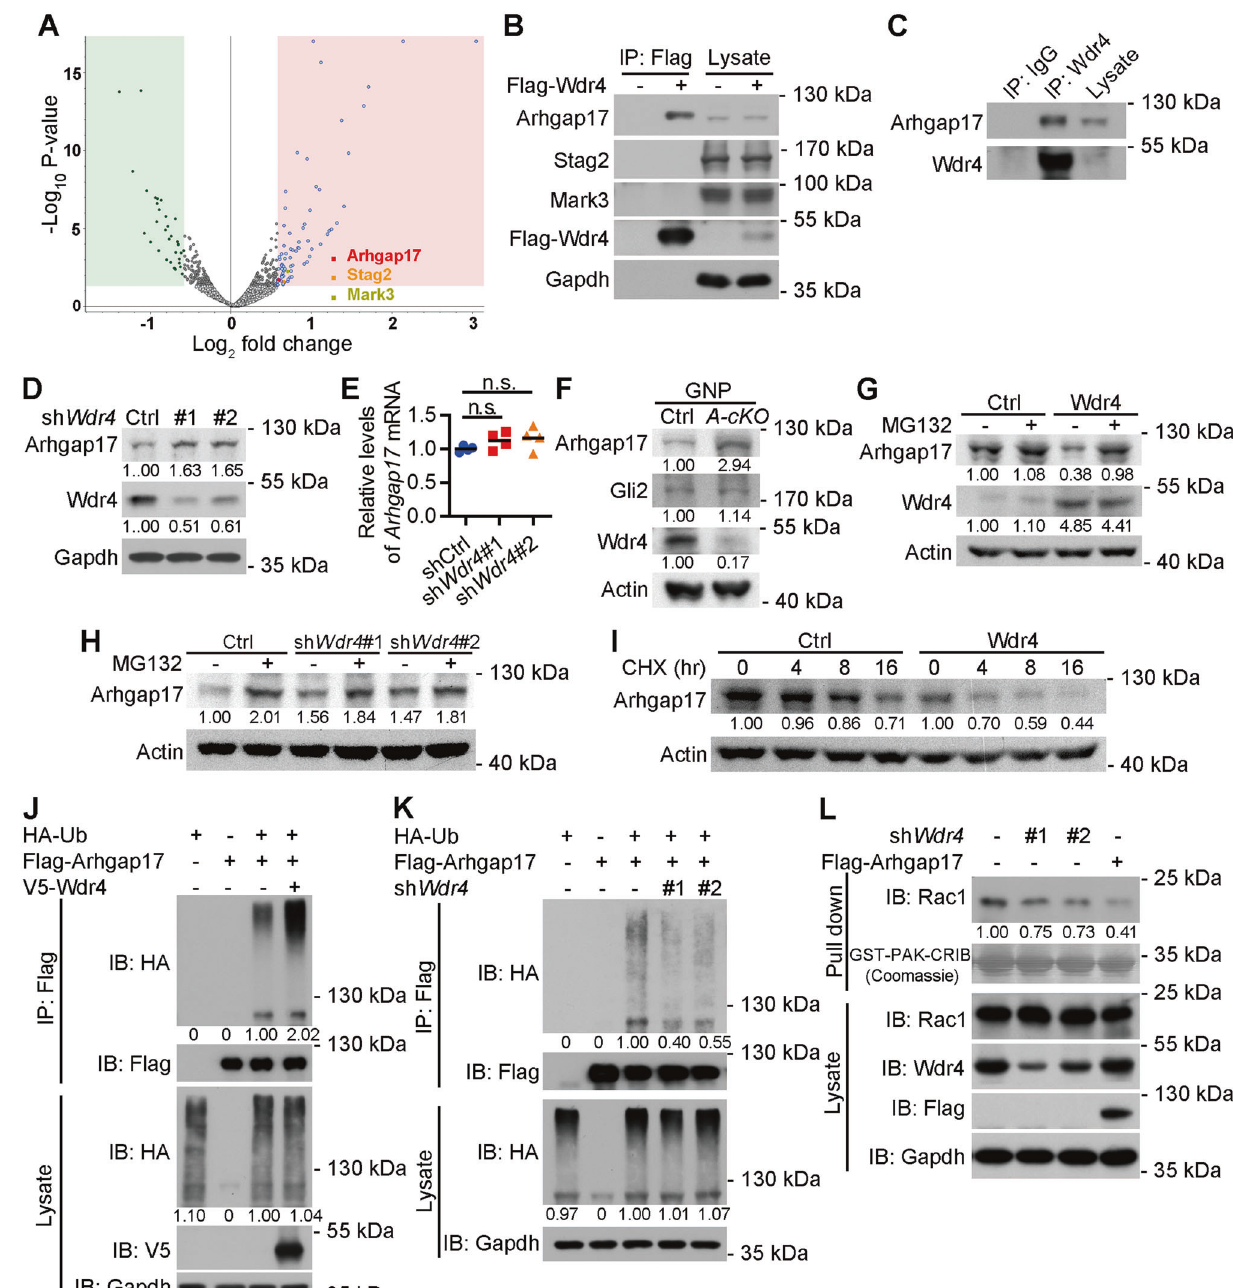
Fig. 6 Wdr4 promotes the ubiquitination and degradation of Arhgap17 to activate Rac1. A The Volcano plot of proteins identi fi ed by LC- MS/MS from GNPs isolated from the P7 Wdr4 A-cKO; Ai14 and control cerebella. Differentially expressed proteins ( p < 0.05 and fold change > 1.5) are marked in blue (for up-regulated) and green (for down-regulated). Among the upregulated proteins, those with a known anti-proliferative function are marked in red, orange or yellow with their names. Data were from 3 cerebella in each group and were analyzed using pairwise-ratio-based, Student ’ s t -test by the Proteome Discoverer 2.3 software. B , C Immunoprecipitation analysis for the interaction between exogenous ( B ) or endogenous ( C ) Wdr4 with indicated proteins. D – E Western blot ( D ) and RT-qPCR ( E ) analyses for the expression of Arhgap17 protein or Arhgap17 mRNA in N2a cells expressing control or Wdr4 shRNAs. Data in ( E ) were from four repeats in each group and analyzed using one-way ANOVA post hoc Dunnett ’ s test, p = 0.3302 in sh Wdr4 #1 v.s. shCtrl, and 0.1855 in sh Wdr4 #2 v.s. shCtrl. Data are represented as individual points and mean. F Western blot analysis for Arhgap17 and Gli2 expression in the puri fi ed GNPs from the P7 Wdr4 A-cKO and control cerebella. G , H Western blot analysis for Arhgap17 expression in N2a cells stably expressing Wdr4 ( G ) or Wdr4 shRNAs ( H ) and treated with 1 μ M MG132 for 16 h. I Western blot analysis for Arhgap17 expression in N2a cells stably expressing Wdr4 and treated with 100 μ g/ml CHX for indicated time points. The levels of Arhgap17 were normalized to the 0 h time point in the control or Wdr4-expressing group, respectively, and indicated at the bottom. J , K In vivo ubiquitination assay using N2a cells ( J ) or N2a cells expressing Wdr4 shRNAs ( K ) and transfected with indicated constructs. L Rac1 activity assay using N2a cells expressing Wdr4 shRNAs or transfected with Flag-Arhgap17. The western blot results were quanti fi ed using ImageJ software. The protein levels were normalized fi rst to the Gapdh protein level in each group and then to the corresponding control groups, and expressed as fold changes at the bottom. All western blot analyses were done at least twice. Cell Death and Disease (2023)